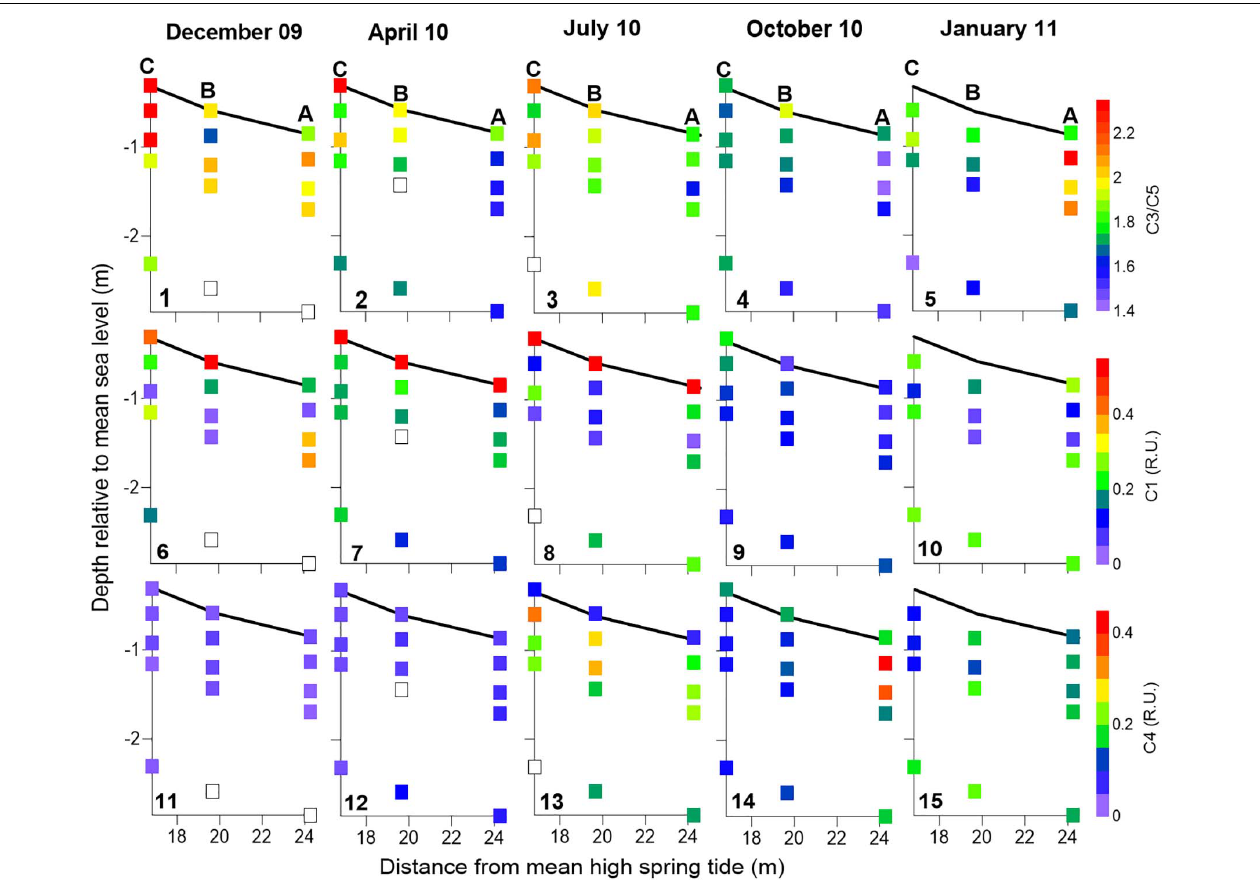
FIGURE 6 | FDOM distribution within the seepage face at the beginning of sediment exposure during low tide. The ratio of FDOM C3/C5 (panels 1–5), C1 (panels 6–10), and C4 (panels 11–15) are shown for the five surveys presented here. Data are represented on the beach profile, where the dark line represents sediment surface. Samples were collected with piezometers buried at different depths and seepage meters. Seepage meter data corresponding to half an hour around the time of piezometer sampling were integrated at each sampling station and presented at the sediment surface. Sampling stations are labeled in the top panels. White squares mean lack of